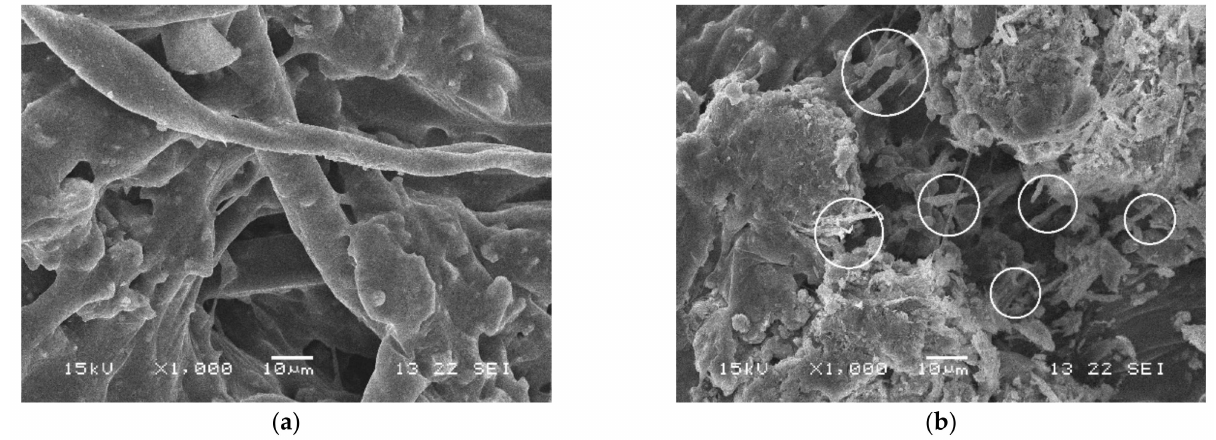
Figure 11. The microstructure of FRCEAM. ( a ) FRCEAM-PF; ( b )